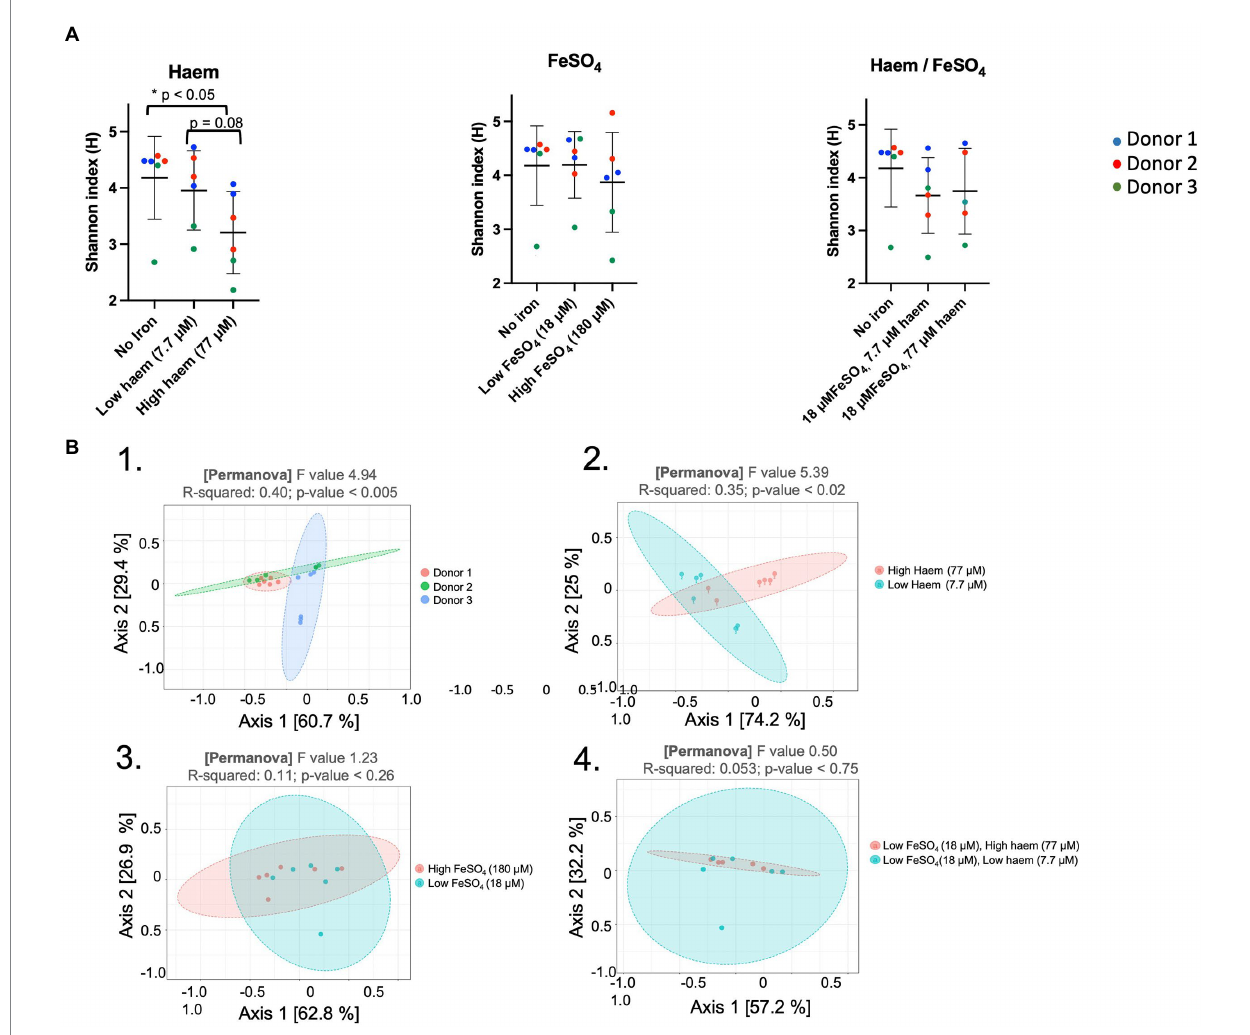
FIGURE 5 Impact of haem and inorganic iron on alpha and beta diversity. Microbiota composition was determined by 16S rRNA gene amplicon NGS. Samples were obtained following incubation in mGMM in the presence of 0, 7.7, or 77 μ M haem, and/or 0, 18, or 180 μ M FeSO 4 after 36 h culture. Data from technical duplicate analyses of each of the 3 donors are presented. (A) Shannon diversity index for microbiota after 36 h of fermentation. Significant differences between the iron regimes are denotated with an asterisk ( p < 0.05). (B) Principal coordinates analysis (PcoA) of Weighted Unifrac distances. PCoA was used to plot beta-diversity of the corresponding microbiota samples: from different donors (B.1); different haem concentrations (B.2); different FeSO 4 concentrations (B3); and different combined concentrations of haem with FeSO 4